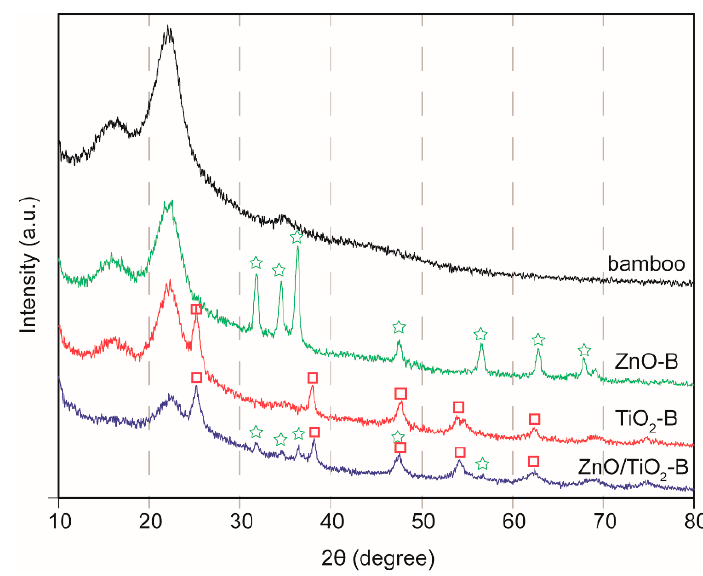
Figure 2. XRD patterns of pristine bamboo, ZnO-B, TiO 2 -B and ZnO/TiO 2 -B.